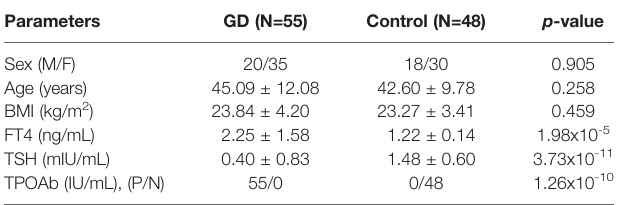
TABLE 1 | Clinical and demographic characteristics of GD patients and healthy controls.